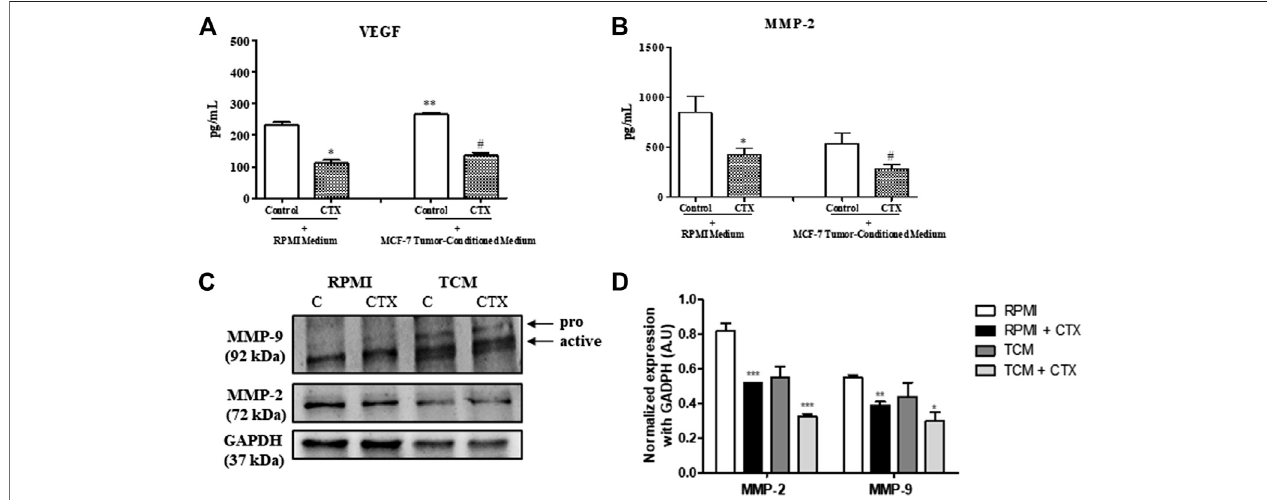
FIGURE 5 | Effect of CTX on the VEGF and MMPs. CTX-pretreated t.End.1 cells were incubated for 24 h in the presence of the fresh medium. Then, the supernatants were collected 99 for measurement of VEGF (A) and MMP-2 (B) concentrations by means of enzyme immunoassay (EIA) using a commercial kit. Data are mean ± s.e.m. Data are the average of four samples of each group ± s.e.m and represent two distinct trials. * p < 0.01, compared to RPMI control group. ** p < 0.05, comparedtoRPMIcontrolgroup,# p < 0.01,comparedtoMCF-7-CM.WesternblottinganalysisofproteinexpressionlevelsofMMP-2andMMP-9 (C) .Thevalues were normalized by GAPDH expression and band intensities were quanti fi ed by densitometry of the homogenate Western blots (D) and represented the mean ± s.e.m. for three samples per group and represent three independent assays. * p < 0.05 by comparison with the respective control groups. ** p < 0.01 by comparison with the respective control groups. *** p < 0.001 by comparison with the respective control